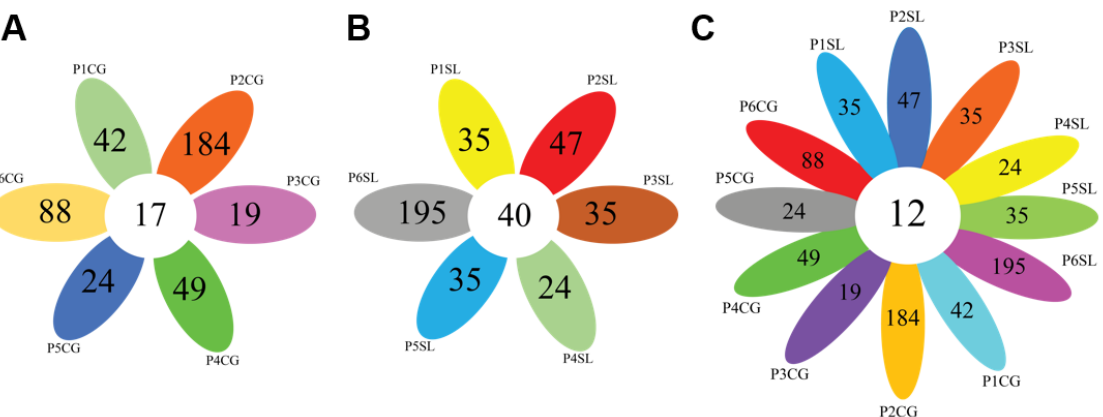
Figure 3. Venn diagrams comparing the number of population-specific and population-shared OTUs. ( A ) Comparison across different populations of Calotropis gigantea , ( B ) Comparison across different populations of Spinifex littoreus , ( C ) Comparison across all C. gigantea and S. littoreus populations. Abbreviations of sampled populations: P-Population (Population 1 to 6, P1 to P6), CG— C. gigantea , SL— S. littoreus .